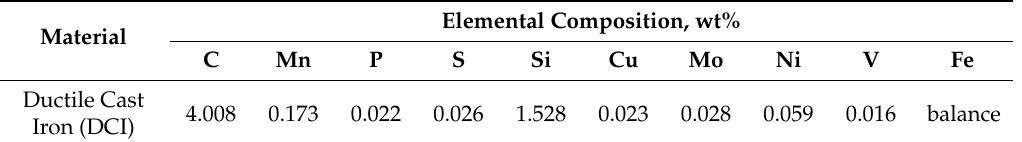
Table 1. Elemental composition of the experimental alloys.